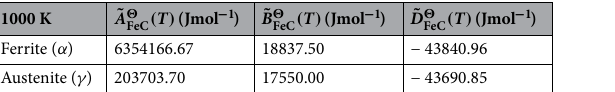
Table 2. Second-, first- and zeroth-order terms of the mole-fraction based free-energy densities of phases in Fe–C system with 0.018 mole-fraction carbon at 1000 K 42 .